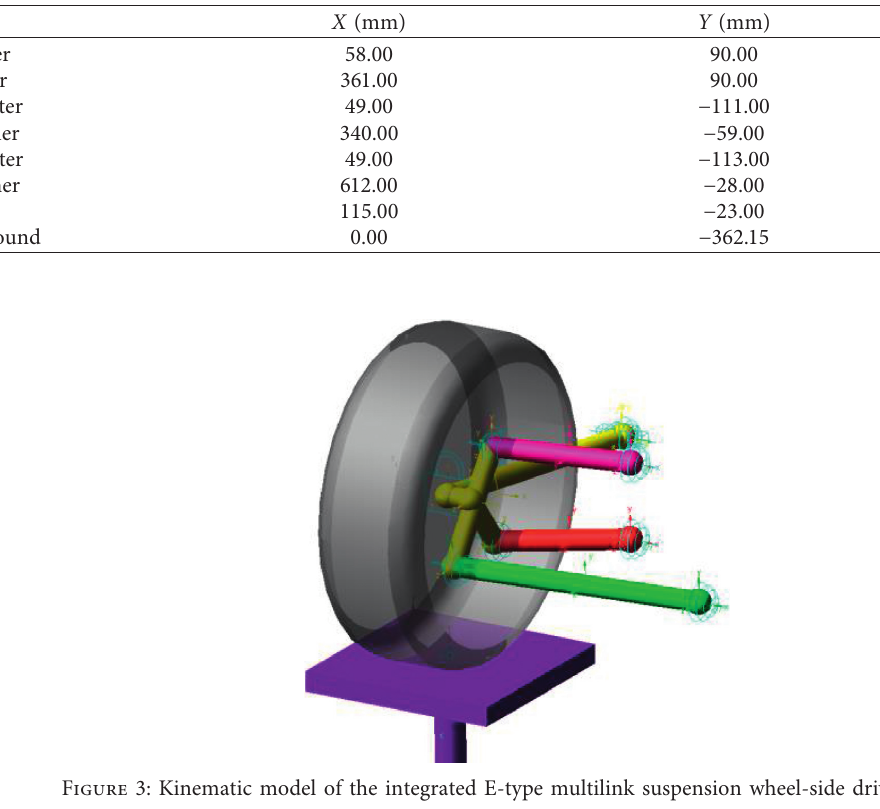
Table 1: Parameters of the modeled positioning points.